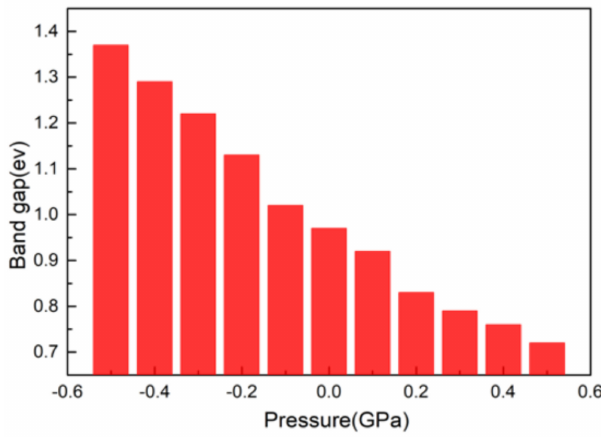
Figure 3. The band gap of CsGeI 3 under di ff erent pressure conditions.